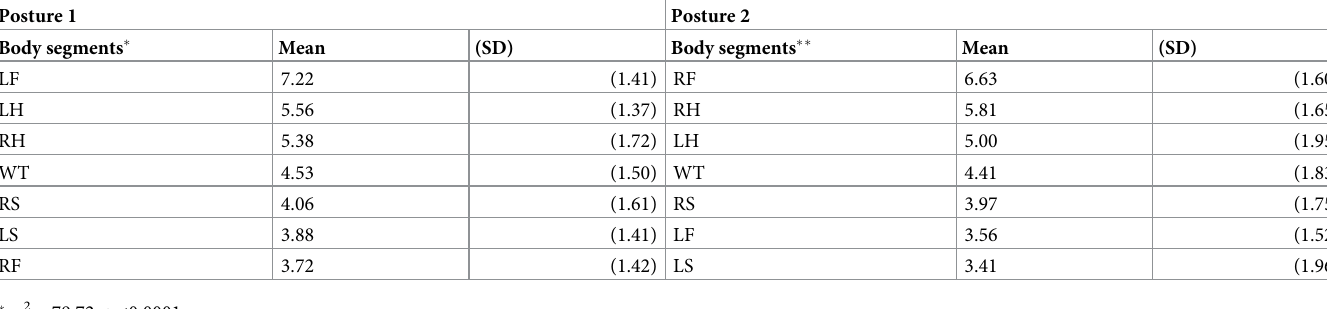
Table 3. CR-10 ratings on body